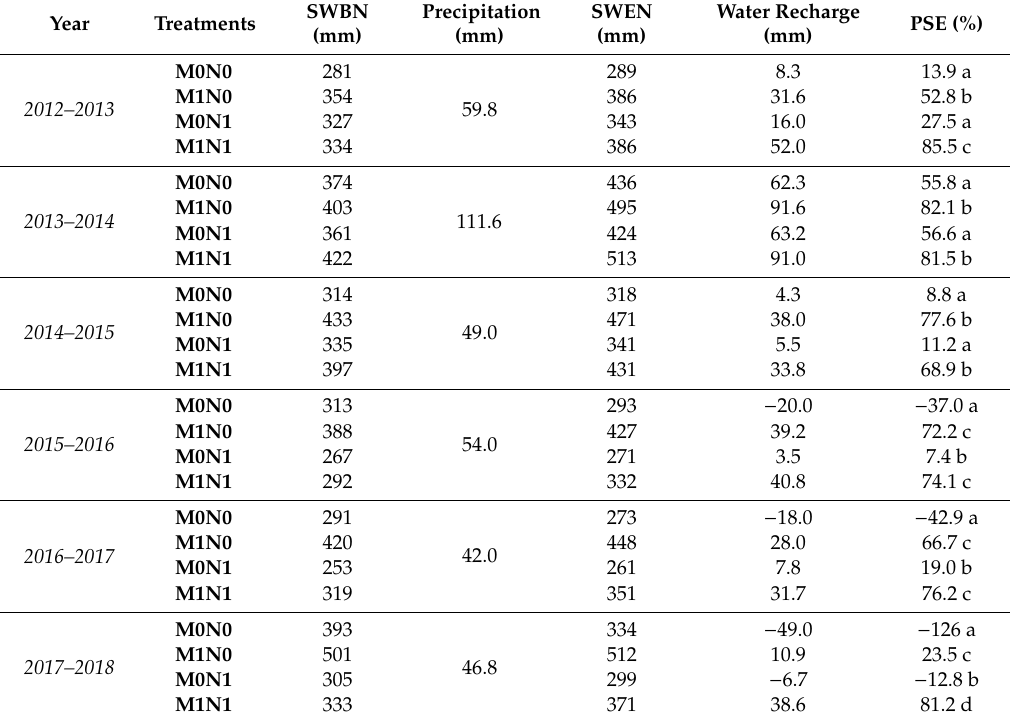
Table 4. Precipitation, water recharge, and precipitation storage efficiency (PSE) in the nongrowing